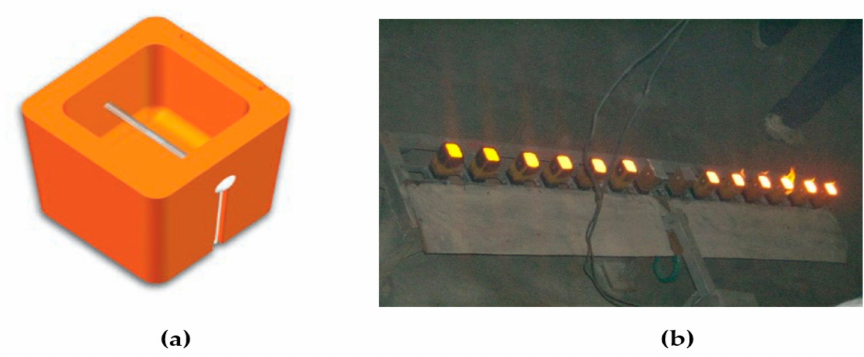
Figure 5. Ceramic cup ( a ) included in a test station for simultaneous thermal (cooling curve) analysis ( b ).